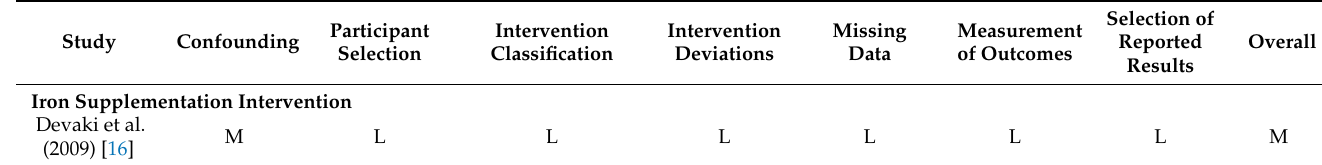
Table 4. Risk of bias summary for non-randomized iron intervention studies assessing academic outcomes or dimensions of